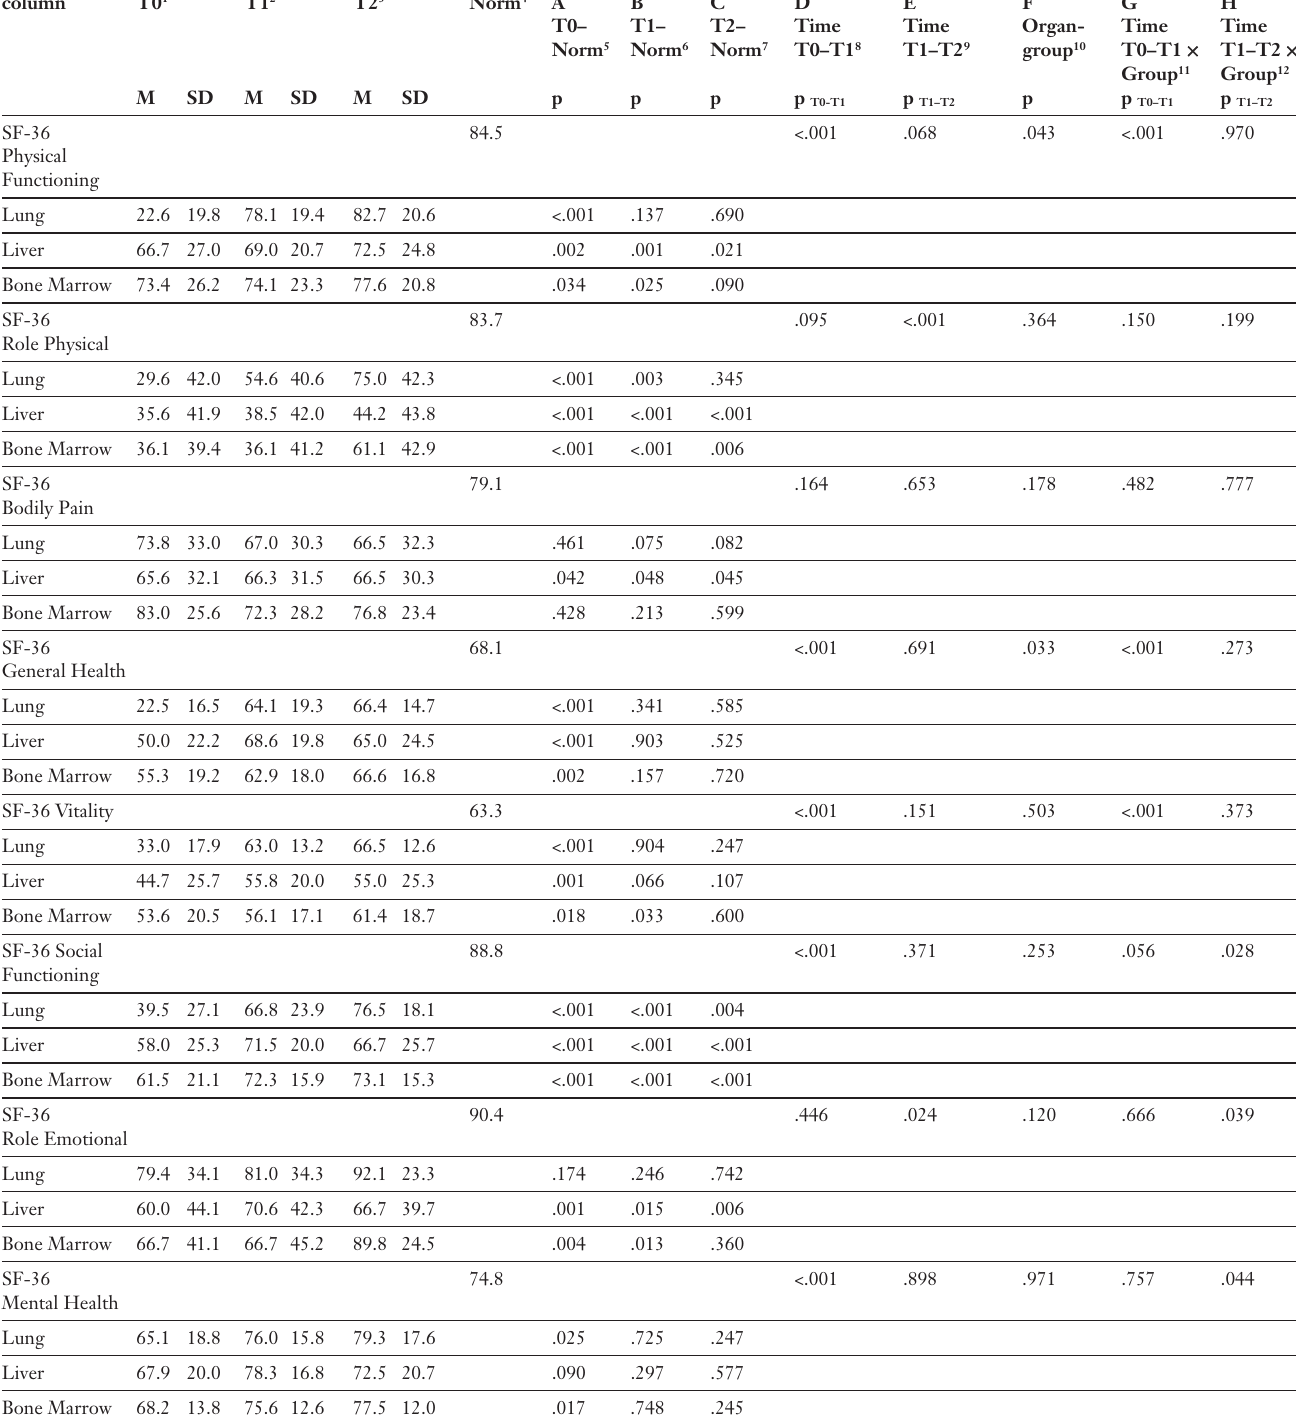
Mean values and standard deviations of the SF-36 subscales before and after a lung, liver or bone marrow transplant (n = 76), differences compared to the norm values [45], differences over the course of time (T0/T1 und T1/T2) of all patients, differences between the organ groups, and differences between the organ groups over time (T0/T1 and